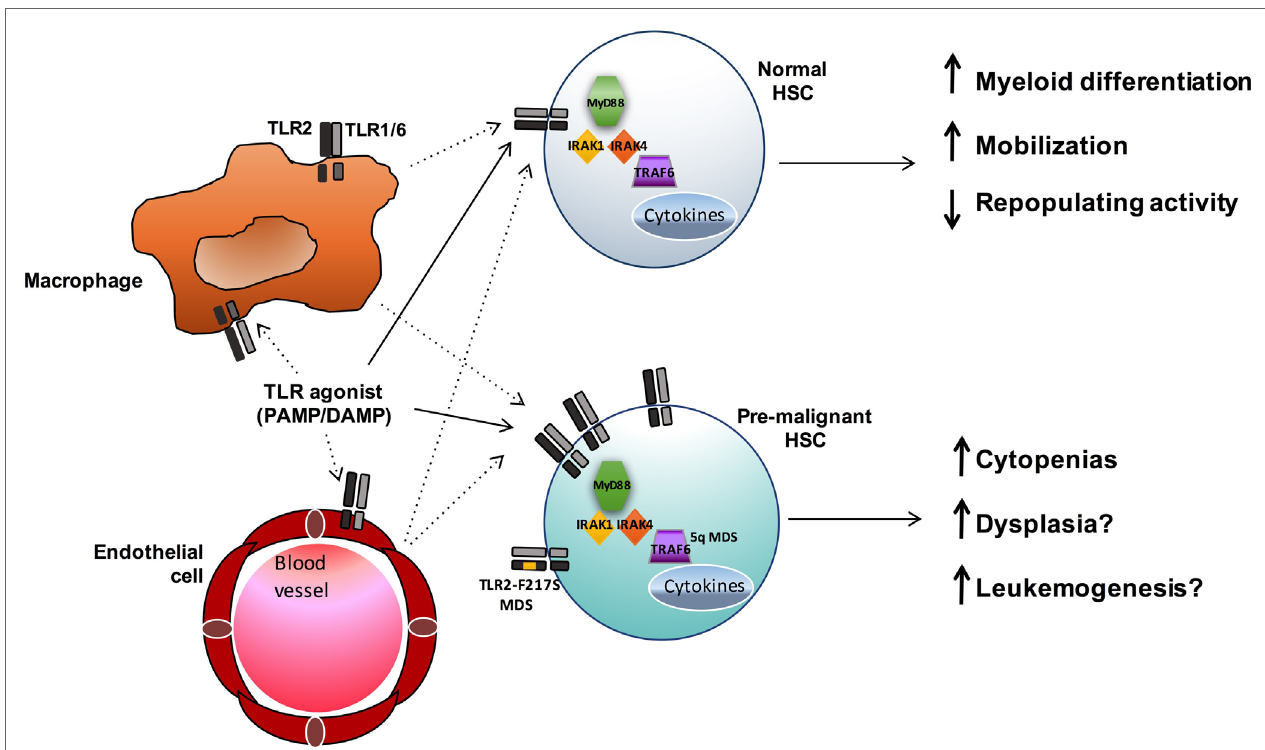
FiGURe 2 | TLR signaling influences both normal and premalignant HSCs . TLR agonists may both directly (solid lines) and indirectly (dashed lines) influence HSCs. In normal HSCs, TLR signals promote myeloid differentiation and mobilization, and sustained exposure to TLR agonists can result in reduced HSC function. In MDS and other hematopoietic malignancies, enhanced TLR signaling ( via increased expression or, in the case of MDS, acquisition of the activating TLR2-F217S variant or increased TRAF6 activity in 5q- cases) may contribute to ineffective hematopoiesis and